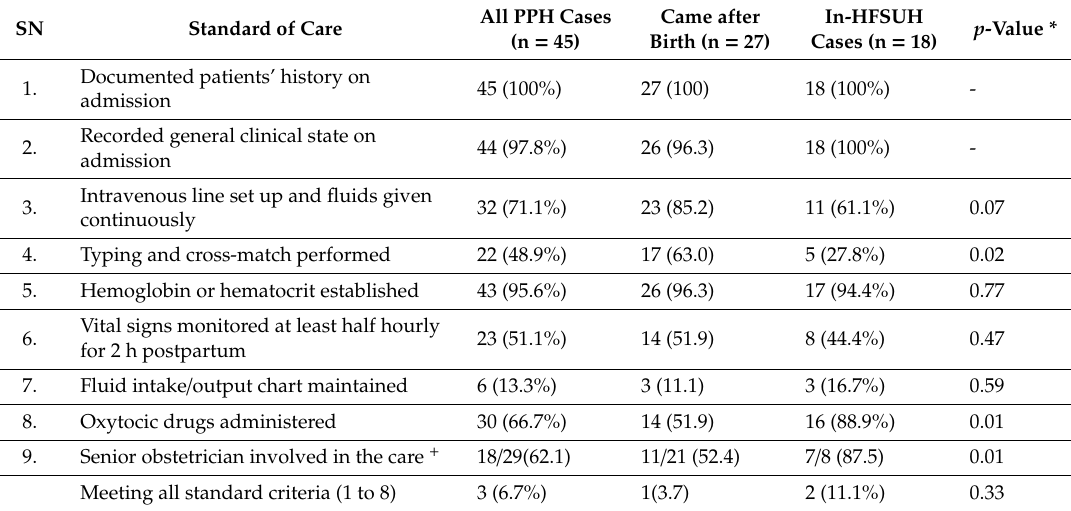
Table 2. Attainment of standard criteria for PPH management in HFSUH,